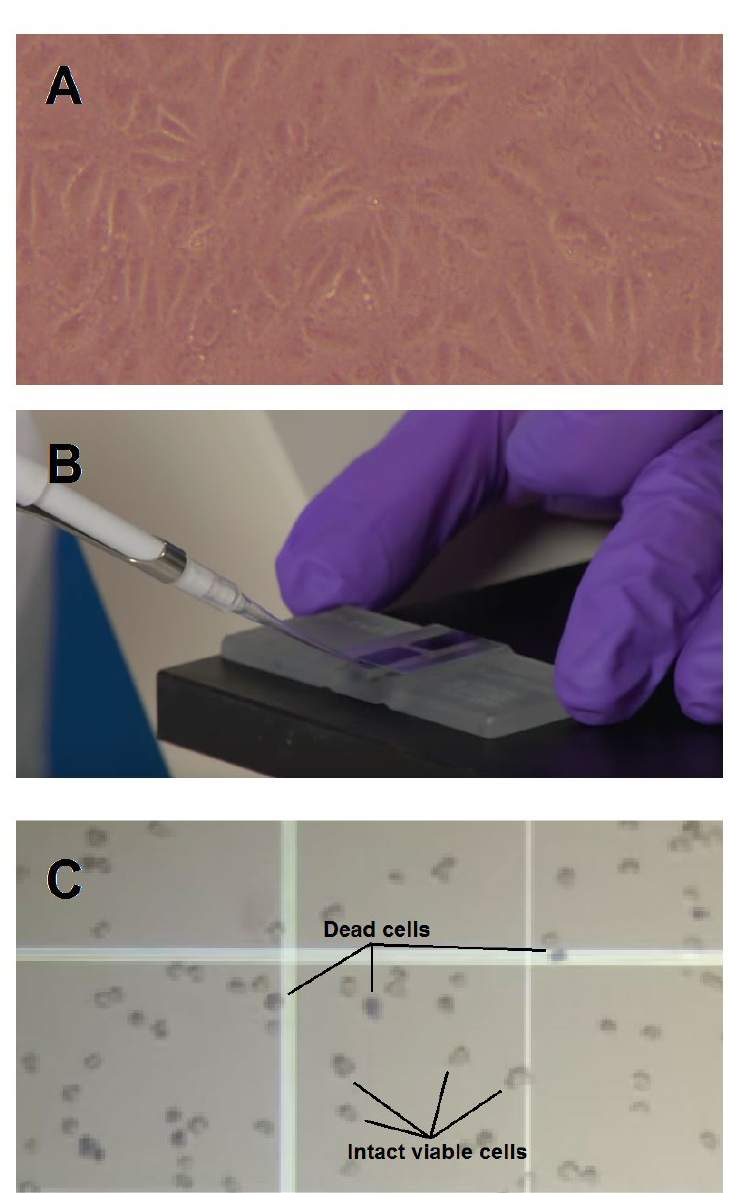
Figure 1. Normal Vero cells used in the study (A), trypan blue staining and preparation for post-thawing viability test (B), hemocytometer microscopic field of study for the stained Vero cells, where stained cells are dead while the unstained cells are intact and viable cells